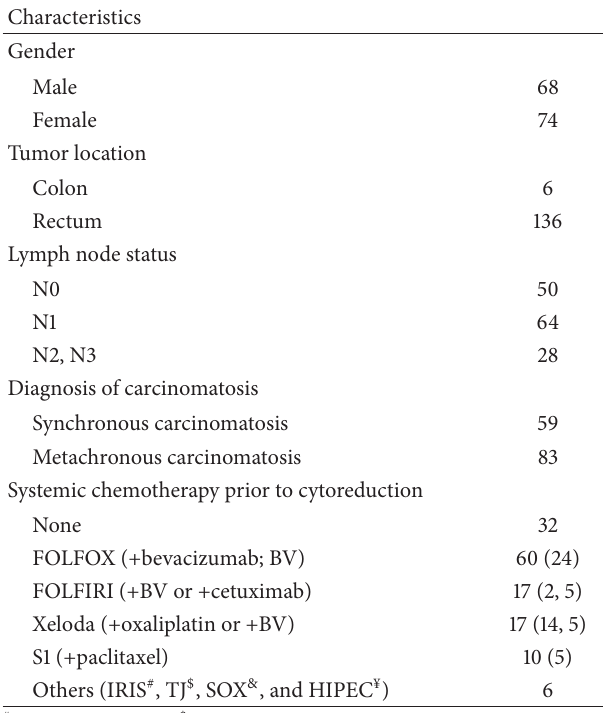
Table 1: Patients and tumor